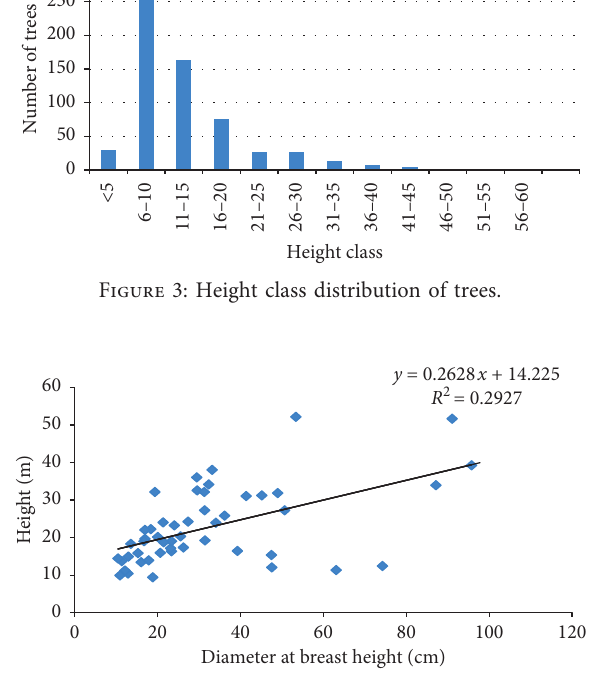
Figure 4: Relationship between height and diameter at breast height.